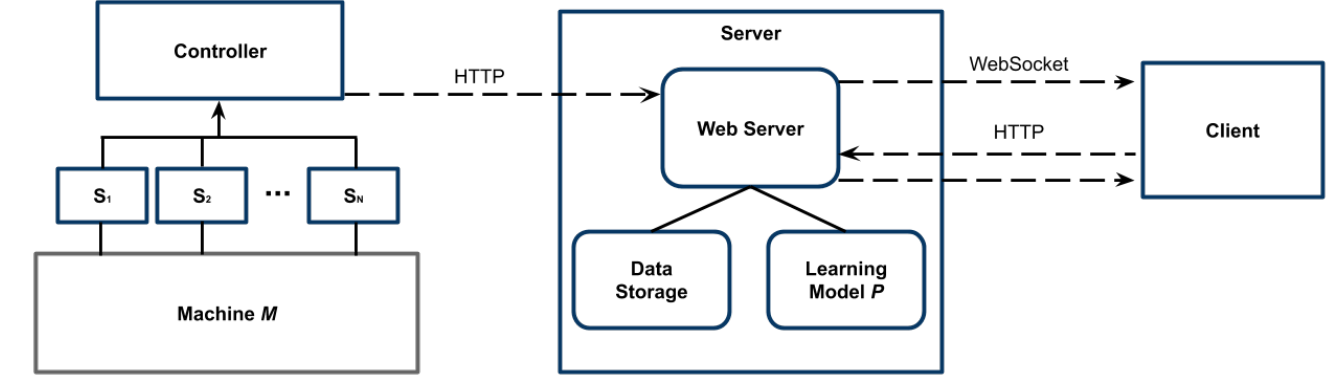
Figure 3. Architecture of the proposed